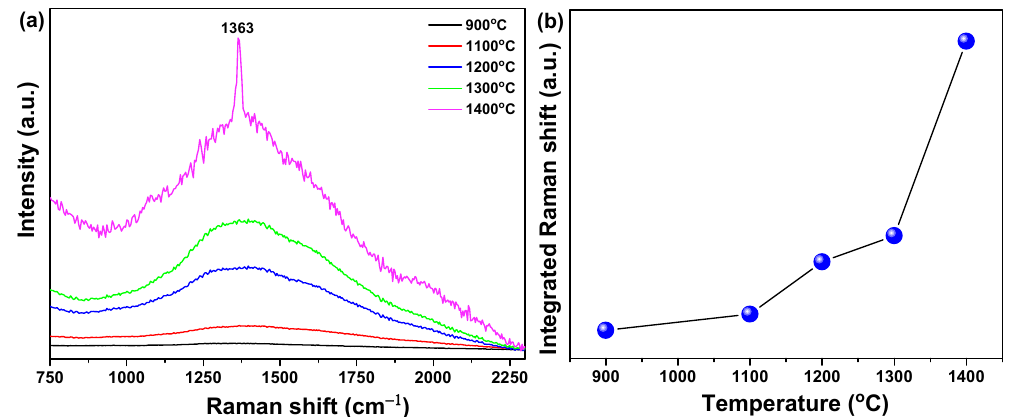
Figure 3. ( a ) Raman shift, ( b ) change of integrated and FWHM (inset) of Raman shift according to 900, 1100, 1200, 1300 and 1400 °C temperatures. In addition, according to the re-heating temperature, the increased integrated area and decreased FWHM of the Raman shift indicate enhanced crystallinity, which is con- sistent with the XRD data. In the case of the specimen pyrolyzed at 900 °C and reheated at 1100 °C, Raman signals were hardly observed. However, when the reheating tempera- ture was increased to 1200 °C or higher, the broad Raman signal strength became stronger and a distinct and strong Raman signal was observed at 1400 °C. This tendency is thought to be a result of the increase in crystallinity with increased reheating temperature. Transmission electron microscopy was performed to observe the shape and morphol- ogy of the synthesized Ce 3+ -doped h-BN nanophosphors as shown in Figure 4. Figure 4a shows a sample pyrolyzed at 900 ℃ and the shape of the nanoparticles is unclear. When the lattice constant (0.332 nm) was profiled with high-resolution, it was found to be close to the XRD result. In addition, carbon was observed (Figure 4c) throughout the sample;